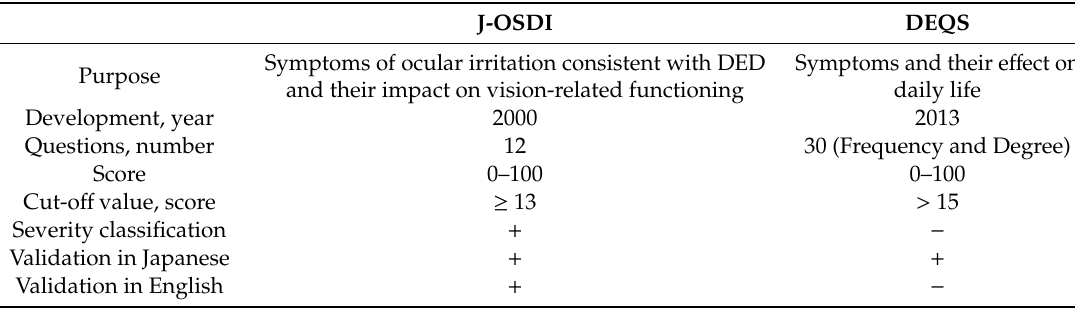
Table 3. Comparison of the J-OSDI and DEQS